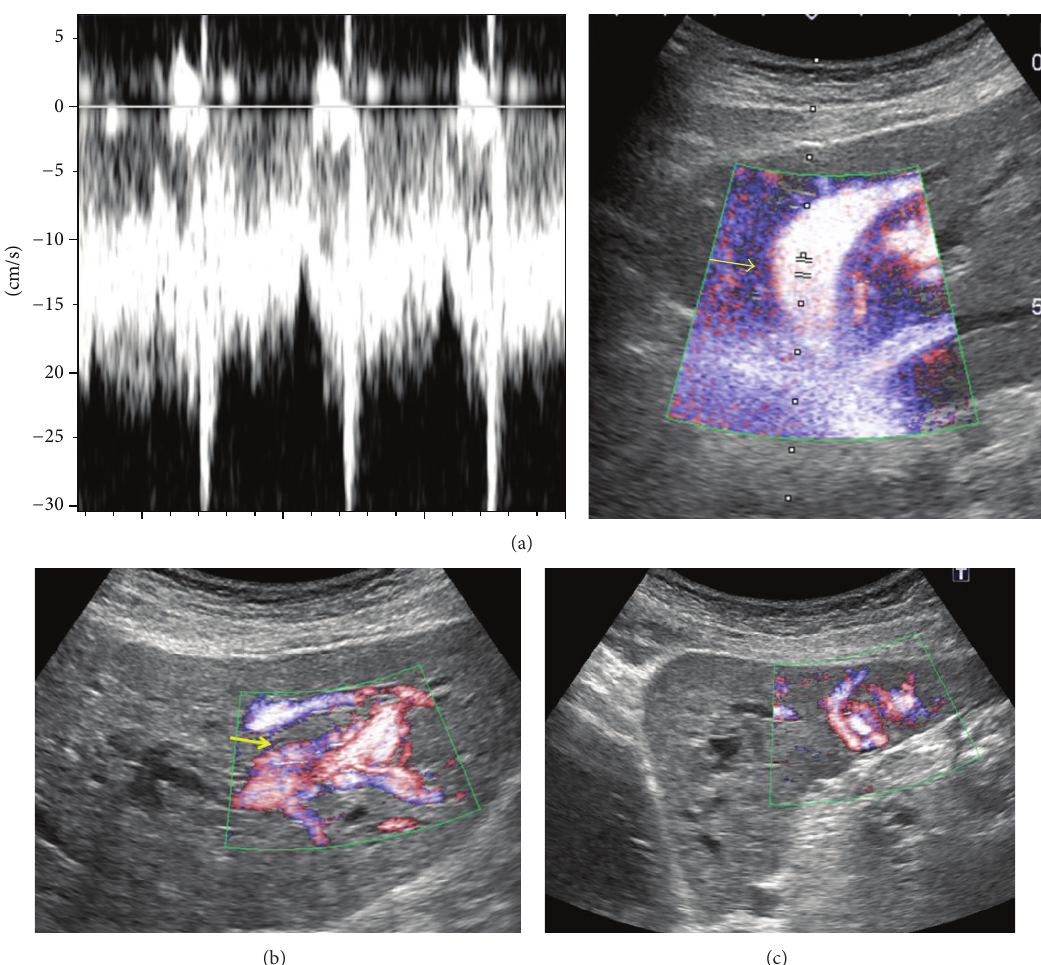
Figure 1: Abdominal ultrasonography with Doppler: (a) significantly dilated hepatic veins (arrow), in which not only venous but also arterial waves are demonstrated, (b) dilated hepatic arteries (arrow), and (c) peripheral vascular malformations.